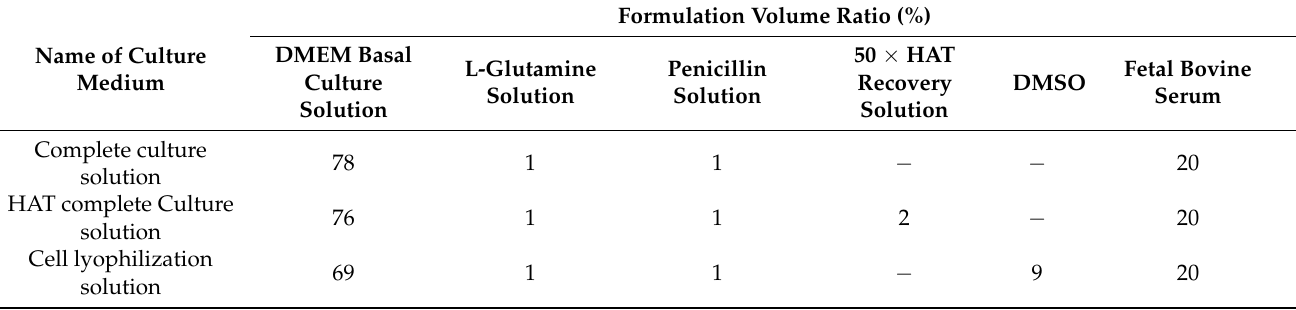
Table 2. Cell culture medium